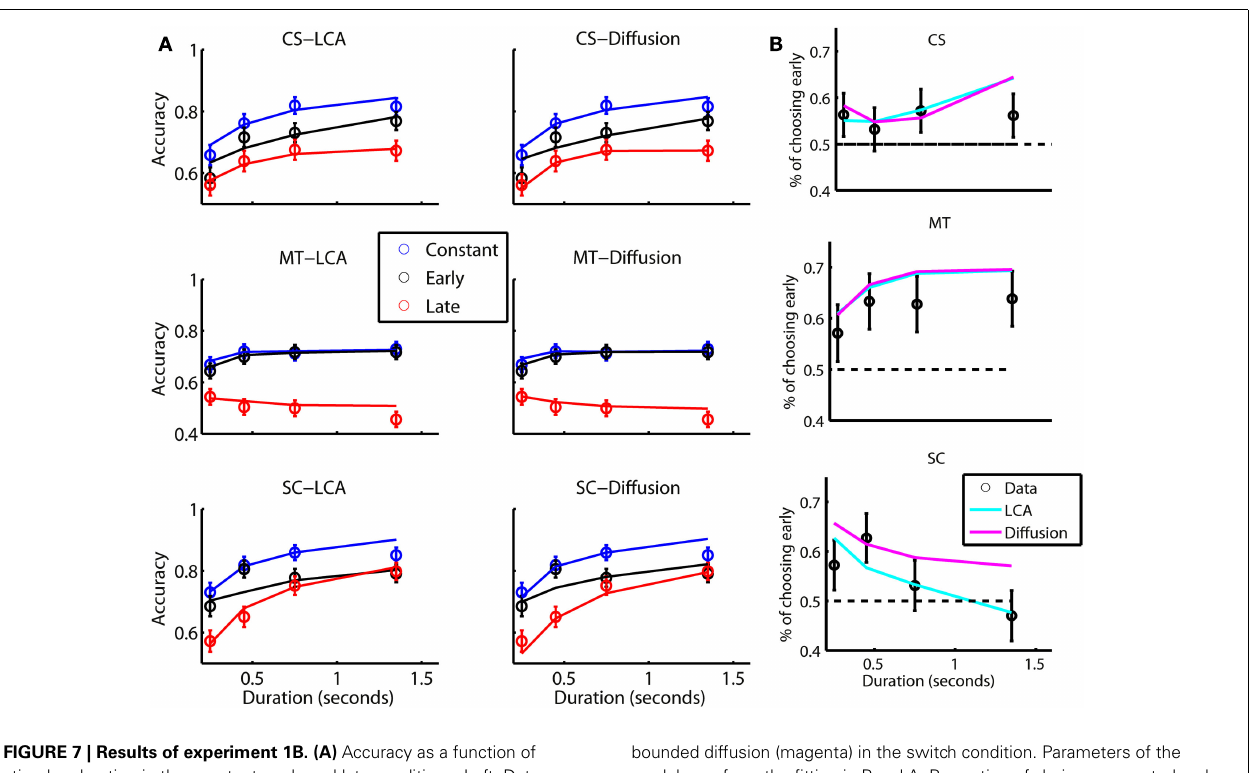
FIGURE 7 | Results of experiment 1B. (A) Accuracy as a function of stimulus duration in the constant, early and late conditions. Left: Data (symbols) and the leaky competing accumulator fit (lines). Error bars correspond to 95% CI. Right: Data and bounded diffusion fit. (B) Predictions of the leaky competing accumulator (cyan) and